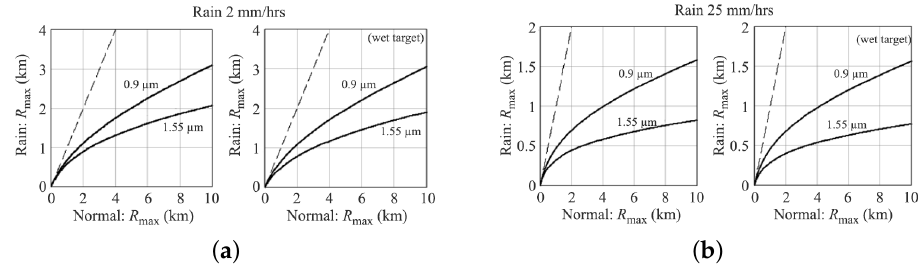
Figure 9. The visibility effects of differing rain intensities and target wetness on 905 nm and 1550 nm waves vs. normal conditions for ( a ) 2 mm/h and ( b ) 25 mm/h rain rate.